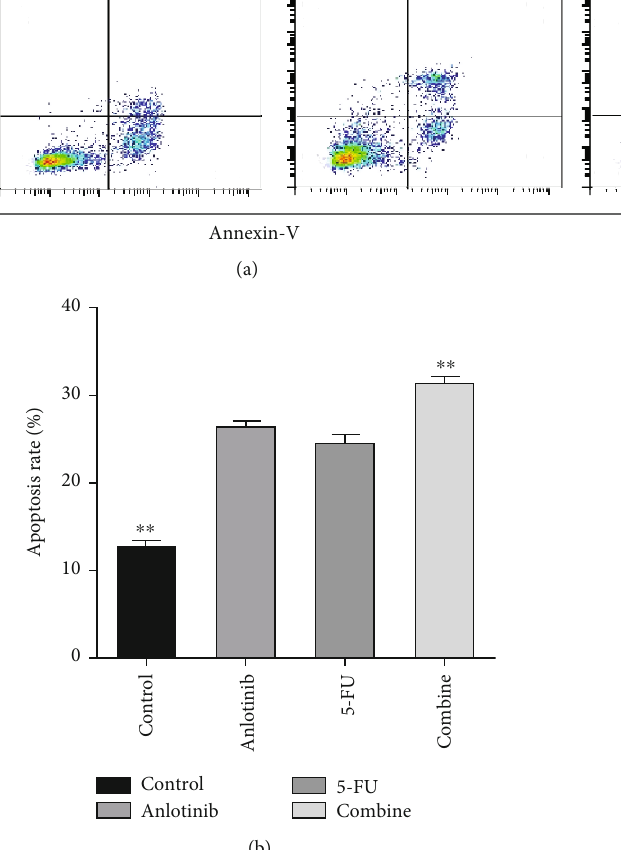
Figure 2: Anlotinib combined with 5-FU induces cell apoptosis in the H446 cells. The cells were treated with anlotinib and 5-FU or combination of both for 24 hours. Apoptosis determined by annexin V-FITC/PI staining by fl ow cytometry. (a) The H446 cells were treated with anlotinib (5 μ M) and 5-FU (10 μ M) or combination of both. (b) The apoptosis rate (%) included Q3 and Q4. All experiments were repeated three times. The bars represent mean ± SEM of the three independent experiments. ∗ P < 0 : 05 and ∗∗ P < 0 : 01 compared with